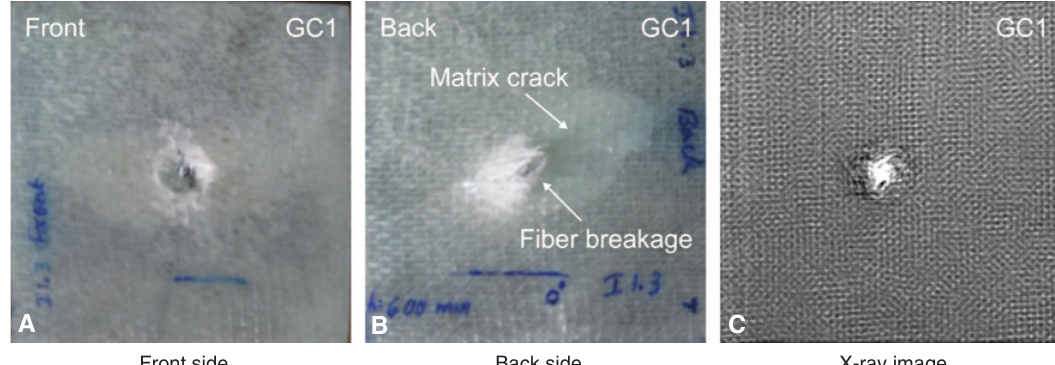
Figure 5: Photographs of impacted specimen GC1.